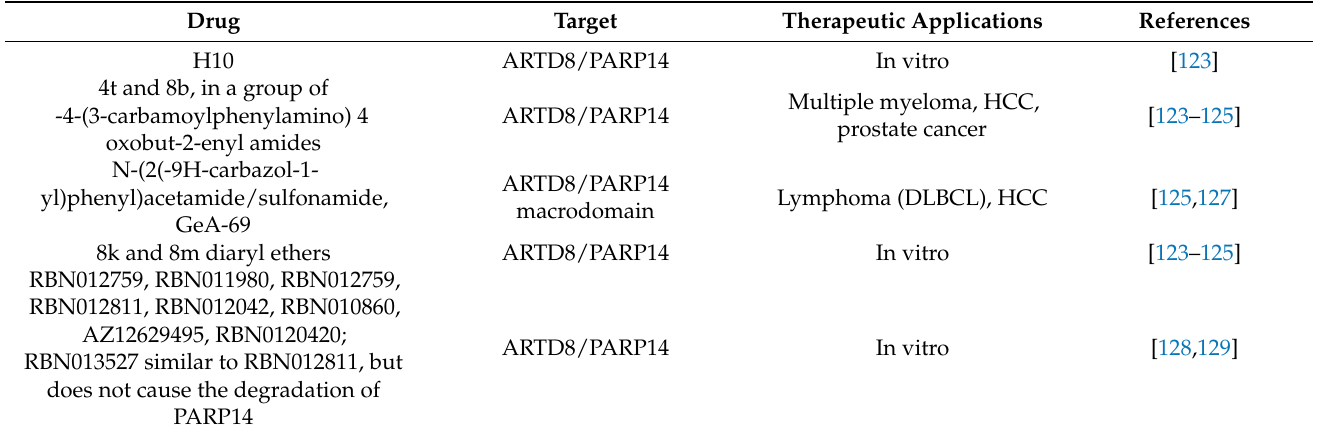
Table 3. Macrodomain containing ARTDs: ARTD8 inhibitors for cancer